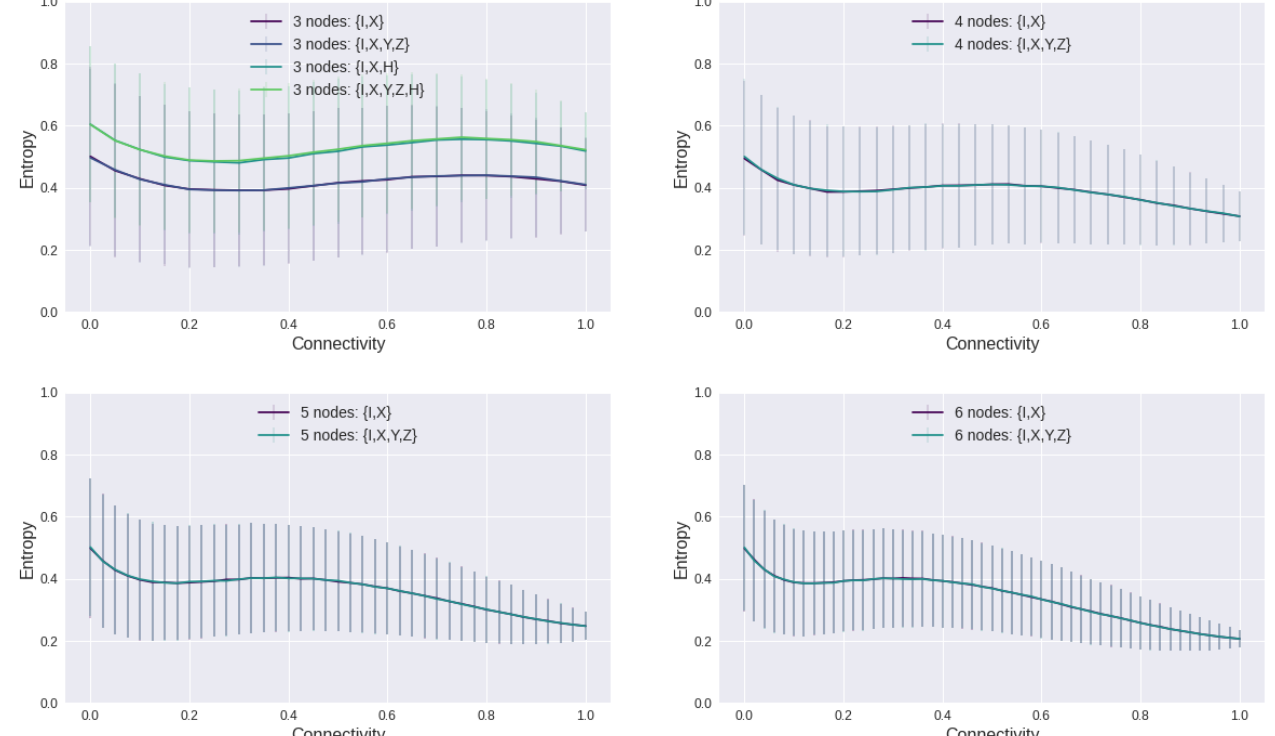
Figure A3. Entropy for QBNs with 3, 4, 5, and 6 nodes. Connectivity is normalized from the range ( 1, N ) . The entropy was computed from 20,000 realizations. For practical reasons (extremely large cycles and computational errors), configurations that can produce superpositions were